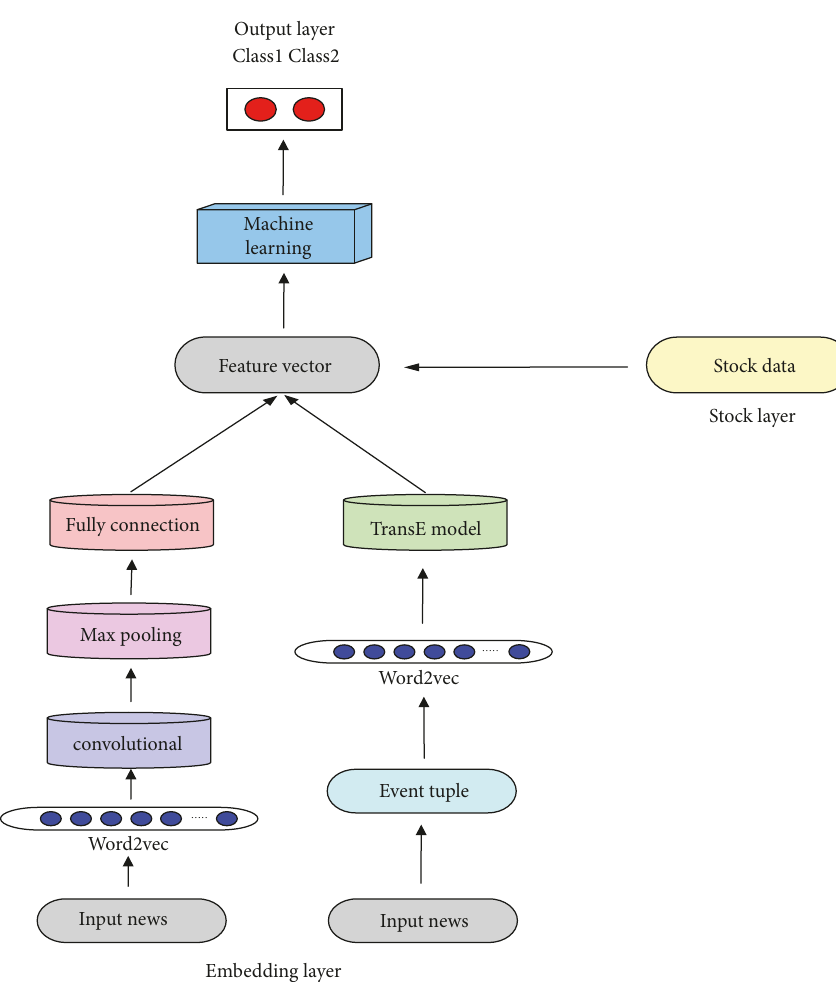
Figure 5: Proposed architecture for the feature combination